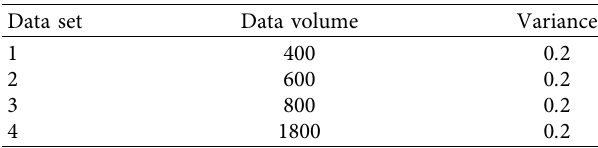
Table 1: Four composite data sets.